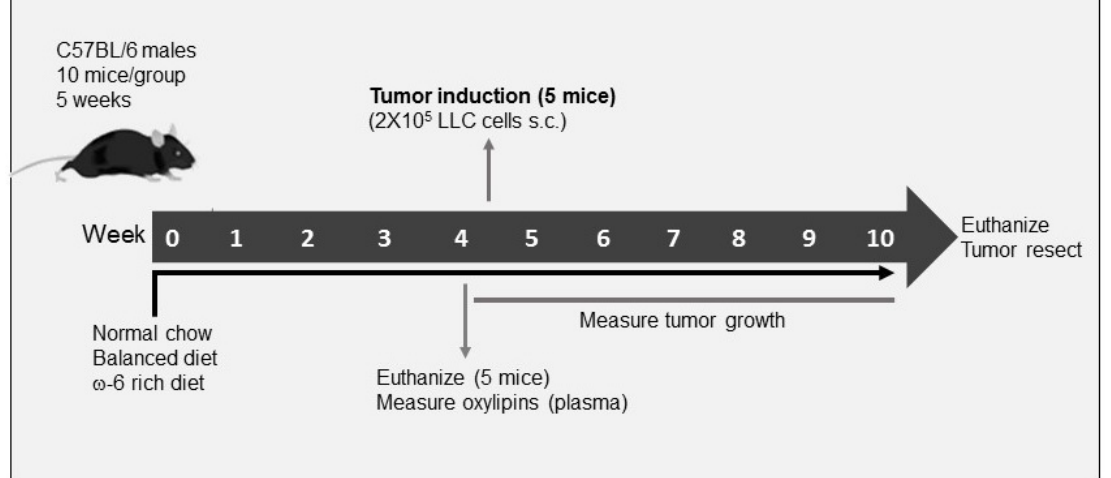
Figure 1. Murine model of the effect of dietary PUFAs of type ω -6 and ω -3 on tumor aggressiveness. Male C57BL/6 mice received a control, balanced or ω -6 rich diet throughout the experiment. After four weeks, five of the mice from each group were sacrificed and plasma was obtained for further analysis of oxylipins by LC/MS/MS. The remaining five animals were administered subcutaneously (sc) with 2 × 10 5 Lewis lung carcinoma (LLC) cells. The volume of the tumor was evaluated and when it reached a size at least 3000 mm 3 , the mice were sacrificed. The tumor was then resected and divided into two parts: one for histology analyses and the other for RT-PCR.